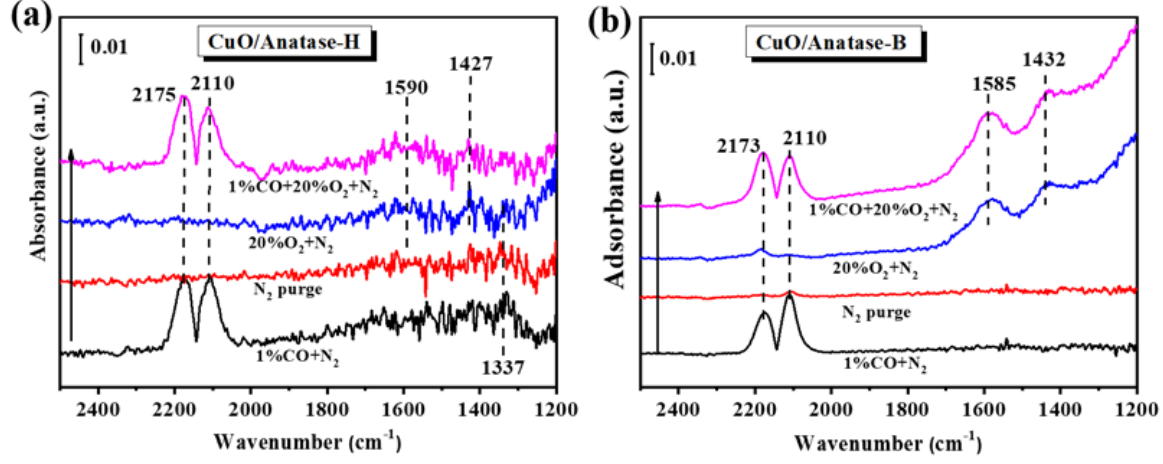
Figure 8. DRIFTS spectra recorded in streams of 1% CO, 5% O 2 balanced by N 2 with a total flow rate of 100 mL/min for ( a ) CuO/anatase-H and ( b ) CuO/anatase-B catalysts at 150 °C. Black arrows stand for the actual order of added atmosphere during DRIFTS experimental process.